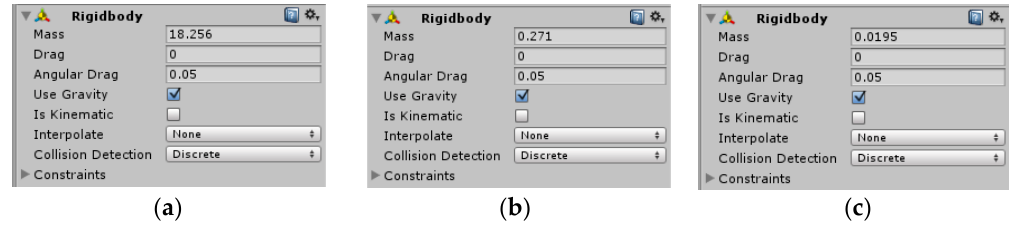
Figure 28. Rigid body components of the roller, hub, and main body: ( a ) rigid body component of the main body; ( b ) rigid body component of the hub; ( c ) rigid body component of the roller.